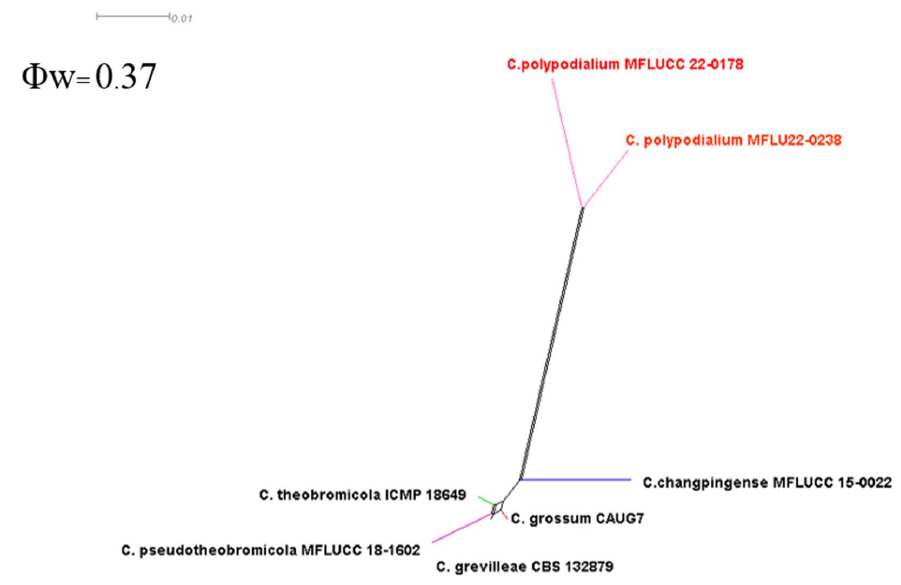
Figure 25. Pairwise homoplasy index ( PHI ) test of closely related species using LogDet transformation . The PHI test results ( Φw ) < 0 . 05 indicate significant recombination within the dataset .